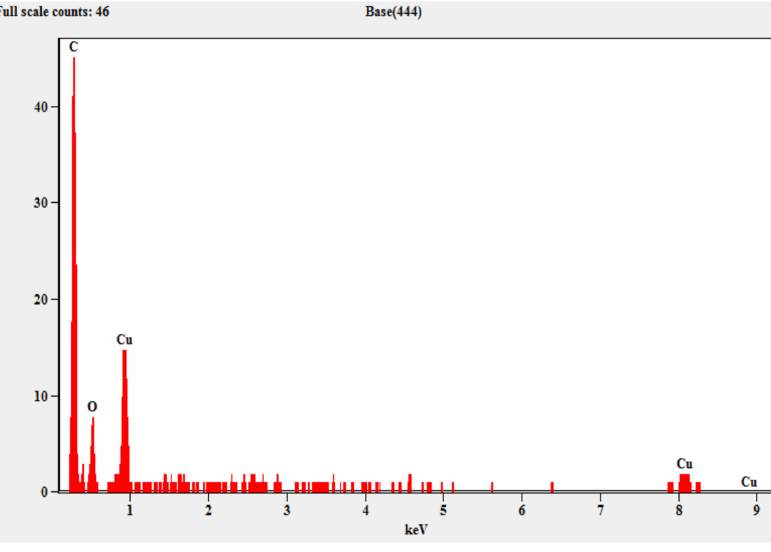
Figure 4. Telmisartan-copper nanoparticle of